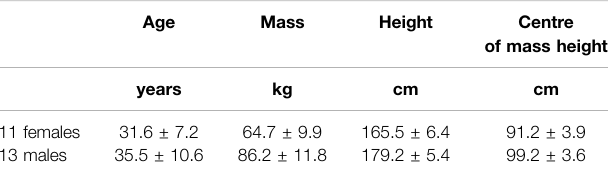
TABLE 2 | Basic anthropometric and demographic data for the volunteers (mean ±